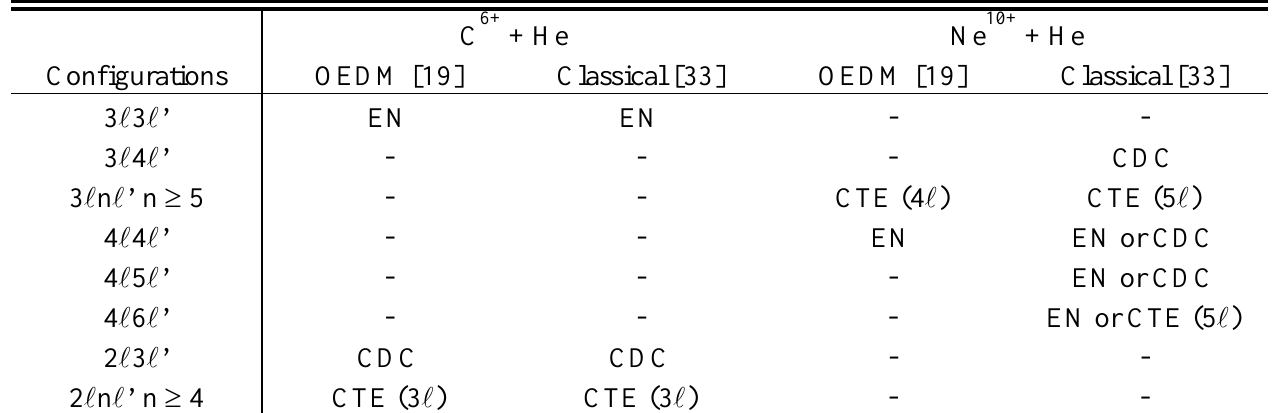
Table 3. Mechanisms responsible for DC in C